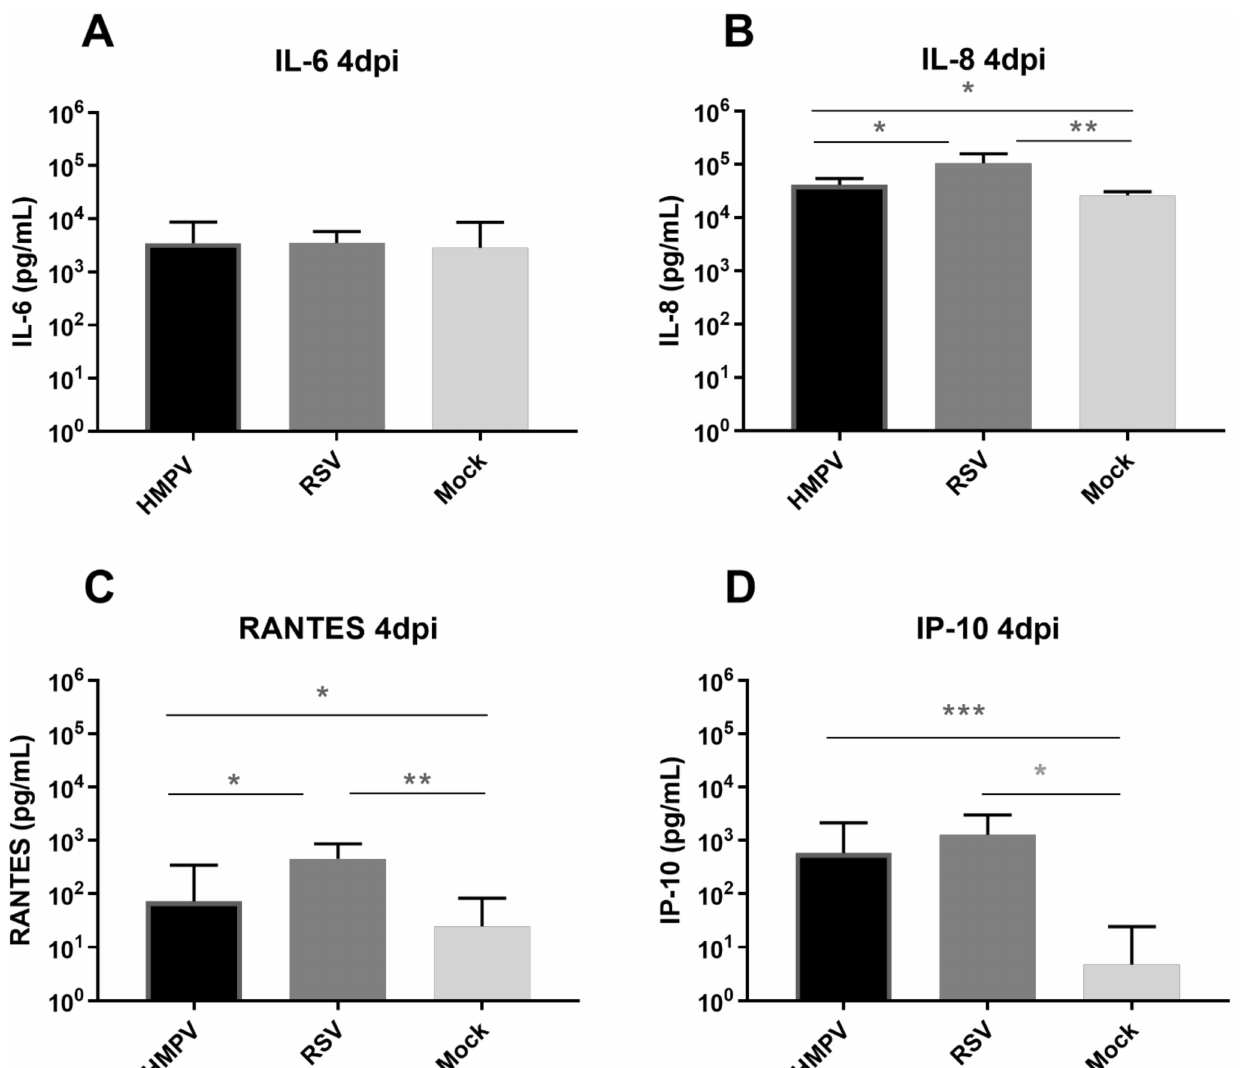
Figure 2. Cytokine induction by RSV and HMPV in in vitro reconstituted airway epithelia. IL-6 ( A ), IL-8 ( B ), RANTES ( C ), and IP-10 ( D ), levels were measured 96H post-infection with RSV or HMPV in daily collected basal medium using ELISA. Statistical significance was calculated using the two-way ANOVA, N = 4. *** p < 0.001;** p < 0.01; * p <